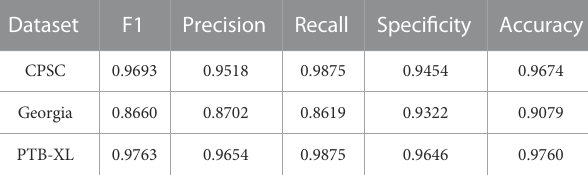
TABLE 5 Performance of AF classi fi cation based on the CPSC and Georgia ECG